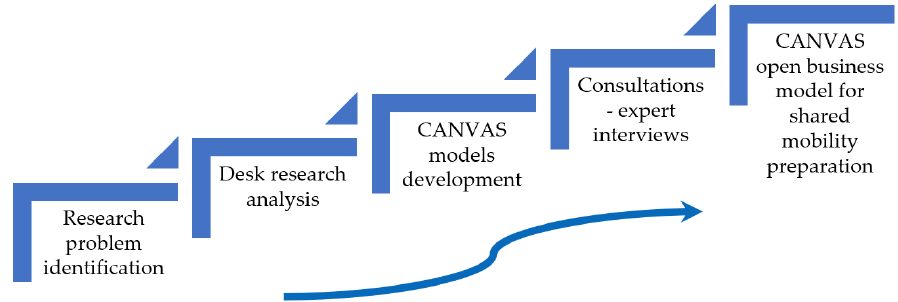
Figure 1. Detailed research plan. Source: author’s own elaboration.